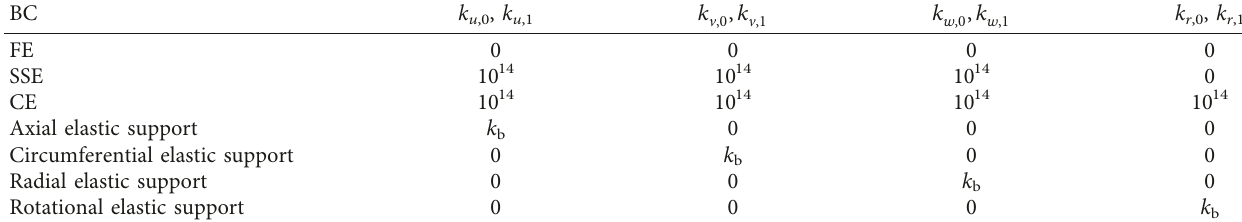
Table 1: Spring stiffness values corresponding to various edge